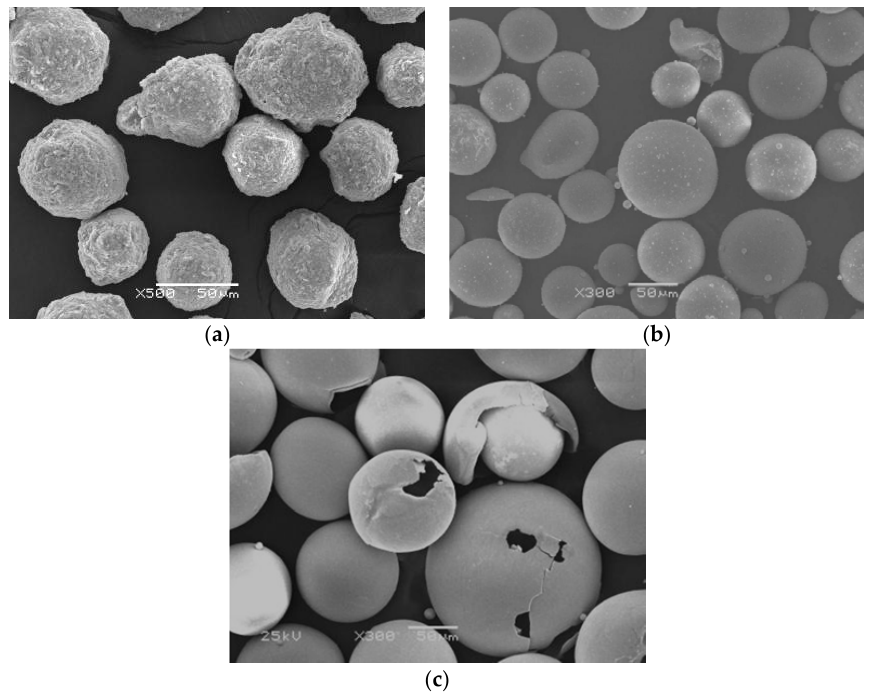
Figure 2. SEM images of yttria ‐ stabilized zirconia (YSZ) powder. ( a ) YSZ agglomerated powder; ( b ) HS1; and ( c ) HS2.